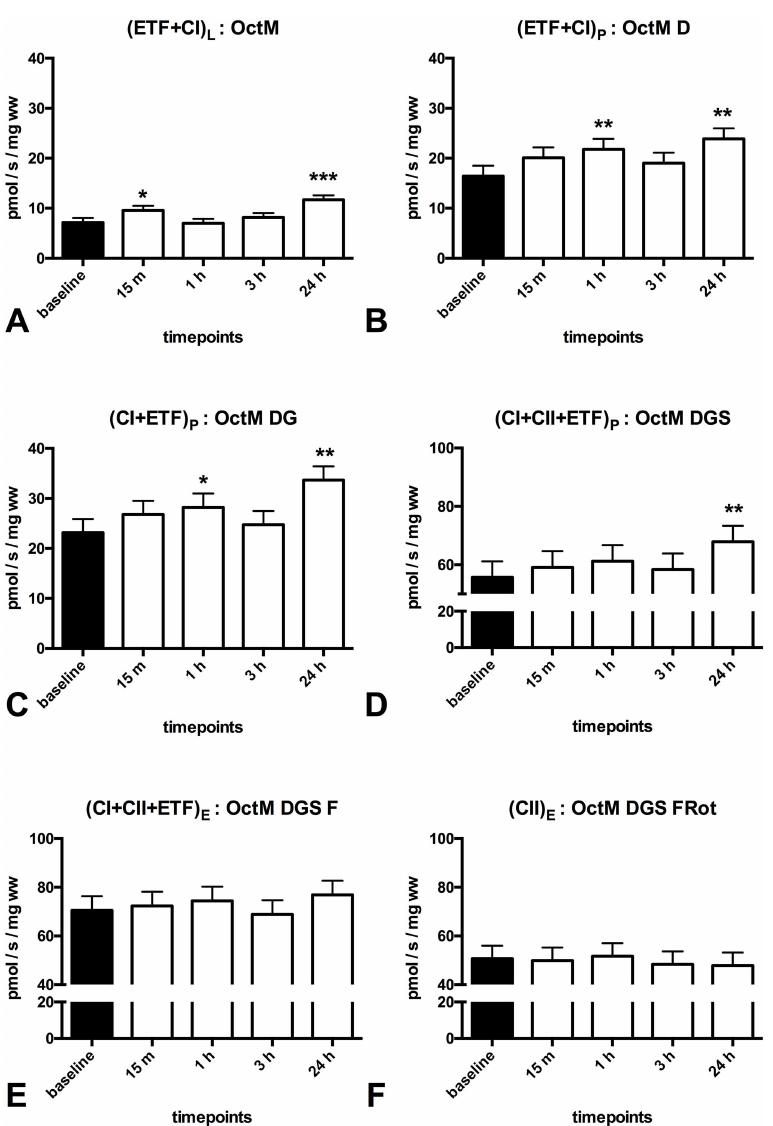
Fig 5. Effect of one session of calf raises upon mitochondrial respiration in healthy older adults. Mitochondrial respiration(pmol O 2 /s/ mg wet weight of muscle fibers) in patients with PVD comparedto at baseline. (A) (ETF+CI)L is the LEAK state electron transfer through electron transferring flavoprotein (ETF) and complex I (CI) after additionof the substrates octanoylcarnitin (0.2mM) + malate (2mM), in the absence of ADP (B) : (ETF+CI)P is fatty acid oxphos capacity after addition of ADP (2.5mM) (C) : (CI+ETF) P is electron transfer through complex I and ETF reaching complex I oxphos capacity after addition of glutamate (10mM) (D) : (CI+II+ETF)P is electron transfer through complex I, II and ETF reaching complex I and II oxphos capacity after addition of succinate (10mM) and ADP (5mM) (E) : (CI+II+ETF)E is electron transfer through complex I, II and ETF reaching ETS capacity after FCCP titrations (0.5M max. 3M) to uncoupleoxidation from phosphorylation (F) : (CII) E is ETS capacity supportedby complex II after addition of rotenone (0.5M), which inhibits complex I. The subscripts L,P,E indicate the LEAK state, OXPHOS and ETS capacity. Oct (0.2mM octanoylcarnitin), M (2mM malate), D (2.5mM ADP),G (10mM glutamate), S (10 mM succinate), D (5mM ADP), F (0.5M FCCP titrations) Rot (0.5 M Rotenon).Black (baseline);white (post-exercise). Values are mean and standard error of the mean, n = 11. * Significantly different from Baseline (P < 0.05), ** Significantly different from Baseline (P < 0.01), *** Significantly different from Baseline (P <